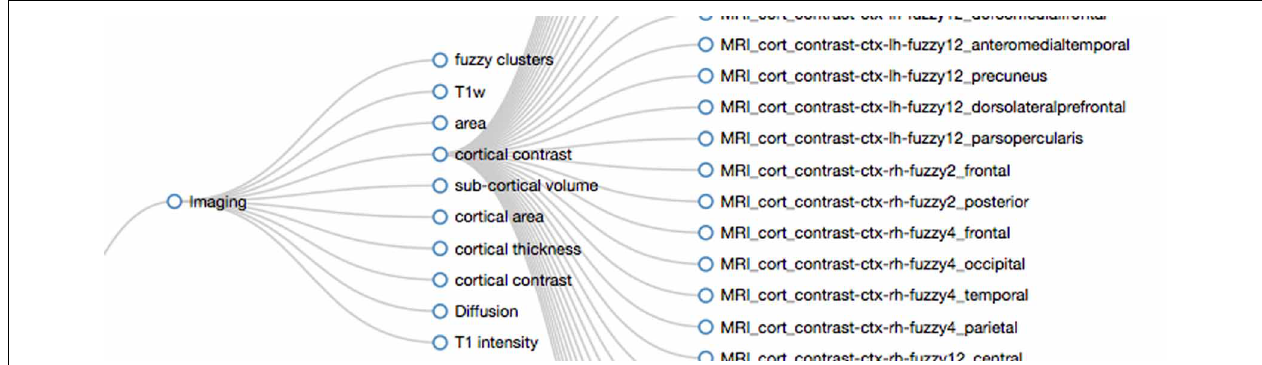
FIGURE 6 | Screen capture displaying parts of the hierarchical structure of the PING data dictionary. The branches for “Imaging” and “cortical contrast” have been opened by the viewer. The regular expression used to create the displayed hierarchy level for “Imaging” is “/(H_area|H_thickness|